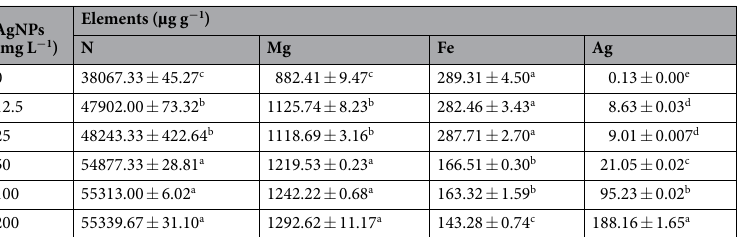
Table 2. Effect of AgNPs on N, Mg, Fe and Ag content in stevia ( Stevia rebaudiana B.) shoots after 30 days of in vitro culture. Means ± standard error within a column followed by the same letter are not significantly different according to Tukey’s test at p ≤ 0.05. Elements: N total nitrogen, Mg magnesium, Fe iron and Ag silver.